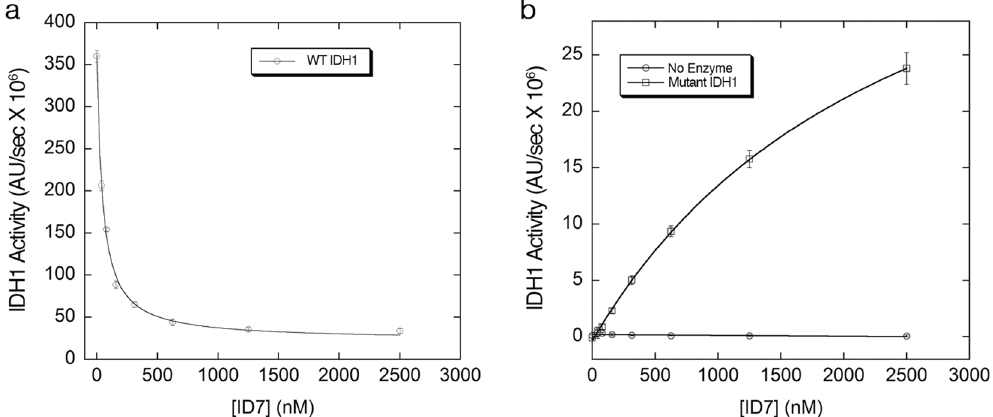
Figure 3. Concentration-dependent effects of ID7 on WT IDH1 and the R132H mutant. ( a ) Fab ID7 inhibits the WT enzyme in a concentration dependent manner with a K i of 45 nM. ( b ) Fab ID7 activates the R132H mutant with a K act of ~2 μ M (squares), but has no intrinsic dehydrogenase activity (circles). Error bars reflect standard